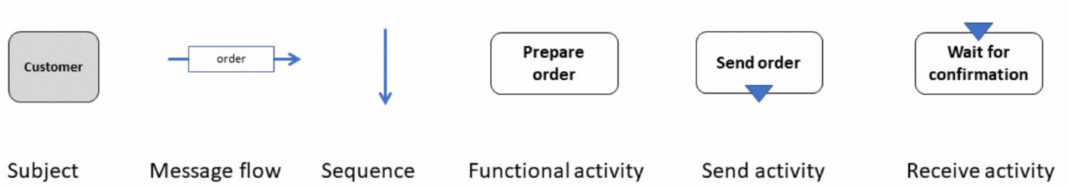
Figure 4. Diagrammatic Subject-oriented Business Process Management (S-BPM) elements for